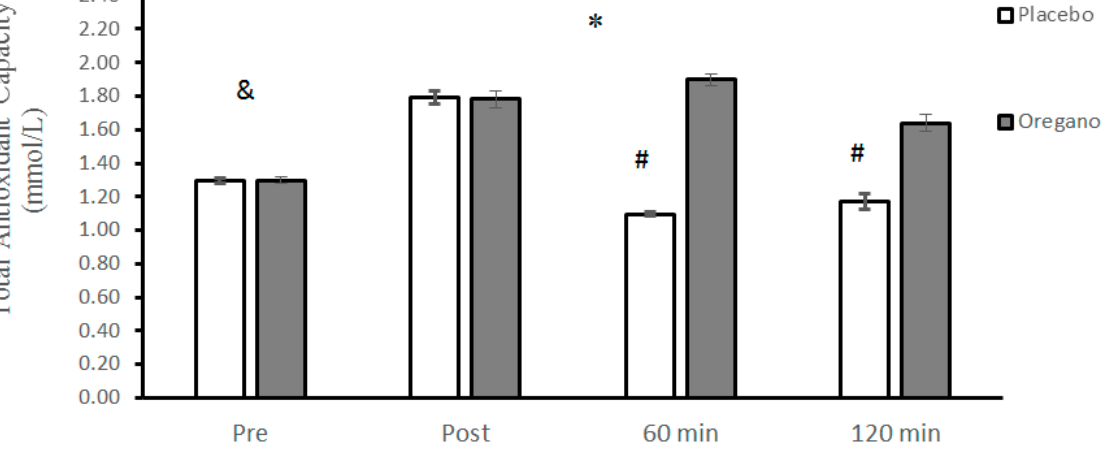
Figure 7. Mean ± standard deviations (SD) of plasma SOD levels before and at different times after consuming oregano supplements. The asterisk (*) indicates significant time × group interaction, (#) indicates a significant difference between the two groups, and (&) indicates the main effect of time ( p < 0.05).